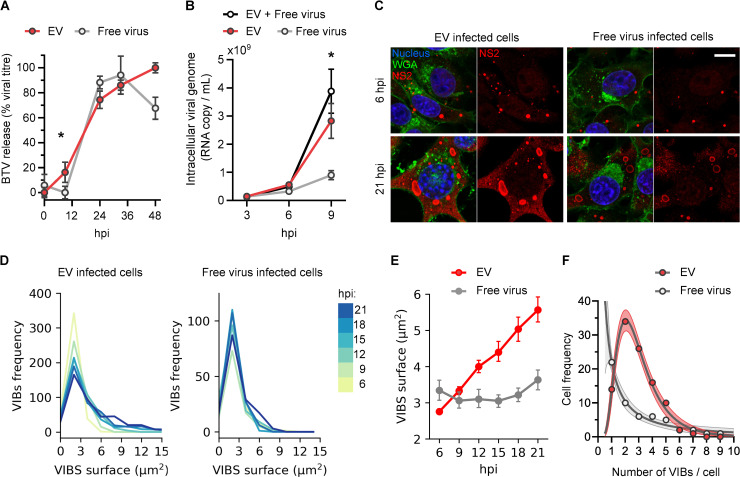
Infection with EVs is more efficient than infection with free virus particles.(A) Kinetics of virus particle release for sheep cells infected with EVs or free viruses. (B) Kinetics of intracellular viral RNA replication in sheep cells infected with EVs, free virus, or both EVs and free viruses. Each point indicates the mean relative titre (percentage of maximum reached infectivity) and vertical lines represent the SDs (N = 3; unpaired t-test between EVs and free virus particles values, *p<0.05). (C) Microscopy images of sheep cells infected with infectious EVs (left panel) or free virus particles (right panel) at 6 hpi (upper panel) or 21 hpi (lower panel). For each condition a merge of the plasma membrane fluorescent marker (WGA, green) with nucleus staining (blue) and viral NS2 labelling (red), or the NS2 labelling only is shown. Scale bar: 10 μm. (D) Frequency distribution of VIB surfaces (μm2) measured in EVs or free virus particles infected cells between 6 and 21 hpi. (E) Kinetics of the increase in VIBs surface area in sheep cells infected with either EVs or free virus particles, derived from the frequency distribution shown in (D). Points indicate the mean surface and vertical lines represent the confidence interval. Multiple t-test showed that VIBs mean surfaces in EVs and free virus infected cells were significantly different at all time points (****p<0.0001). (F) Frequency distribution of the VIBs number/cells, after 6 hours of infection with EVs or free virus particles. Points represent the number of cells, lines represent the log normal regression analysis of the cell distributions (R2 = 0.98) and the shaded area represent the confidence interval (95%).